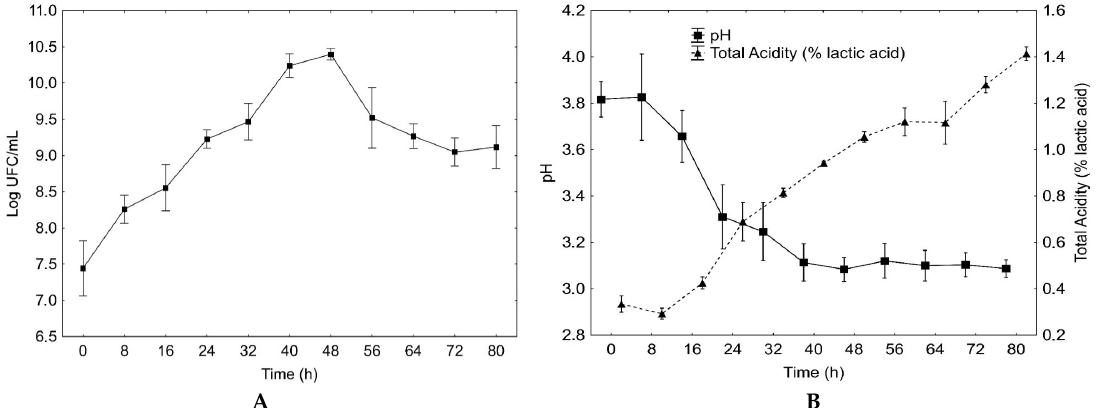
Figure 1. Viability of Lactobacillus reuteri ( A ), and pH ( ■ ) and acidity (% lactic acid) ( ▲ ) ( B ) for 80 h of fermentation in blueberry and carrot blend at 32 °C. The results are presented as the mean of three repetitions and standard deviation.